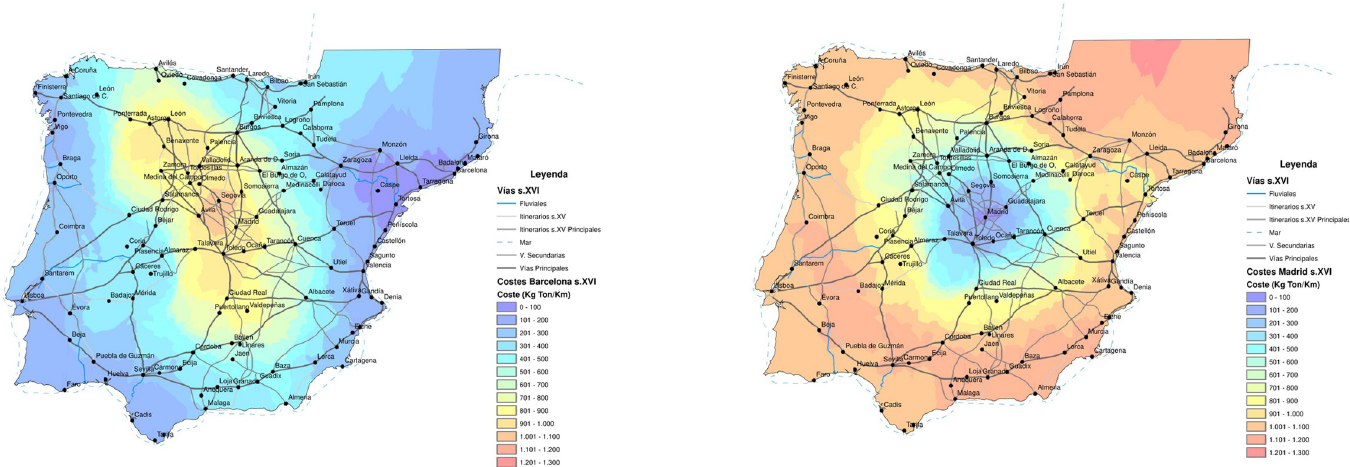
Fig 4. Comparison of transport costs for Barcelona and Madrid. Source: Reprinted from Carreras Monfort and Soto [70] under a CCBY license, with permission from UPC University Press, original copyright 2010. A. Barcelona, B. Madrid.